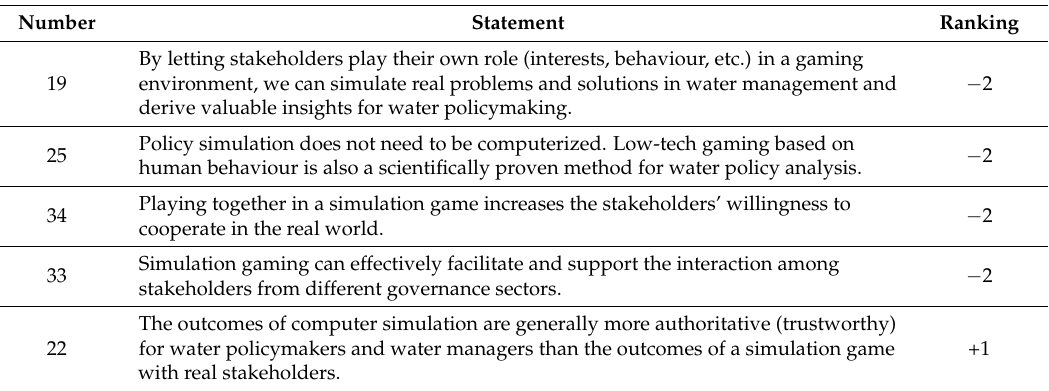
Table 12. Distinguished statements about MSG in frame